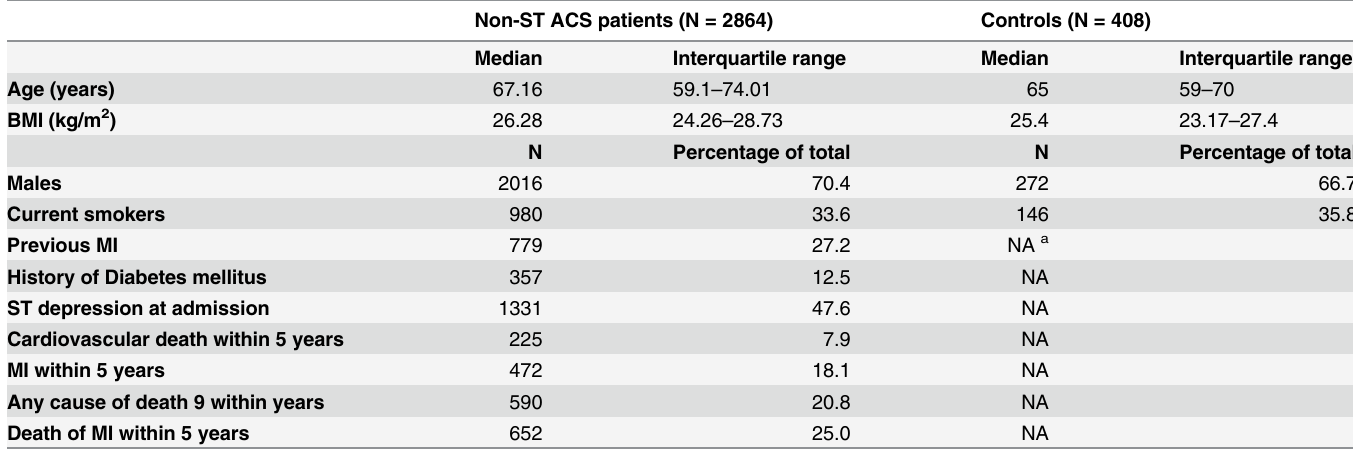
Table 1. Characteristics of the study